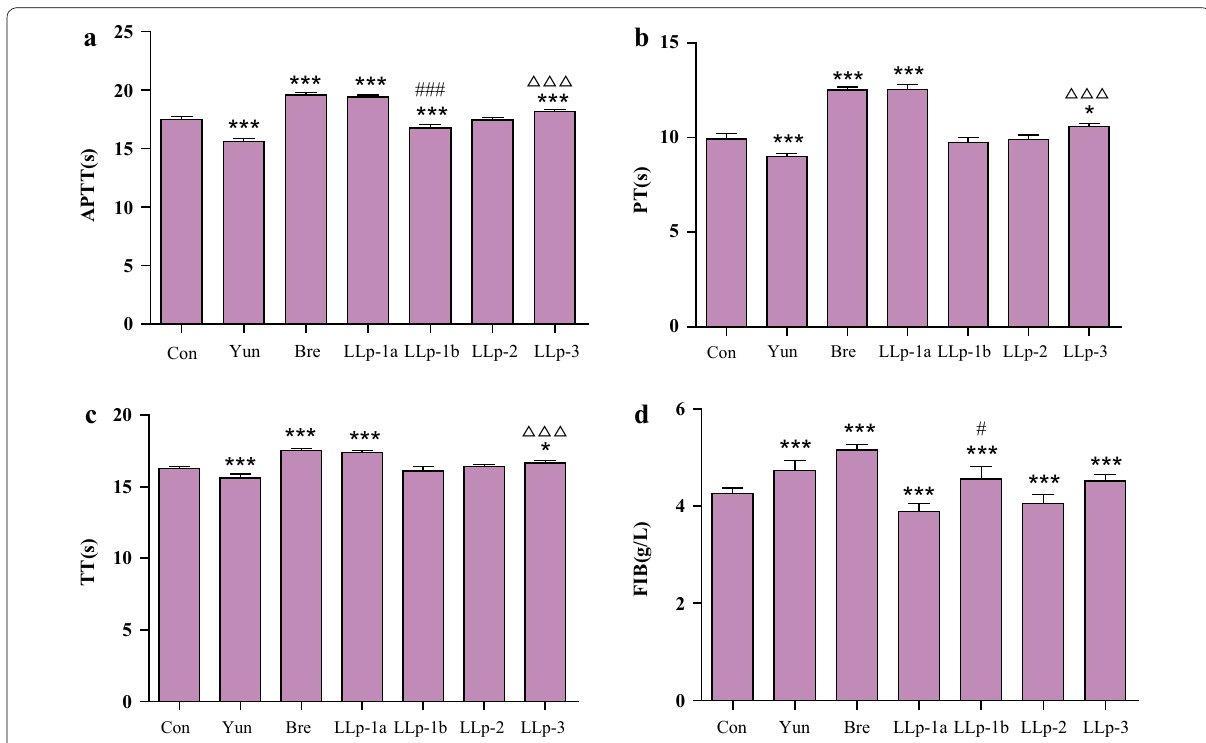
6). Compared with control group, ***p < 0 =